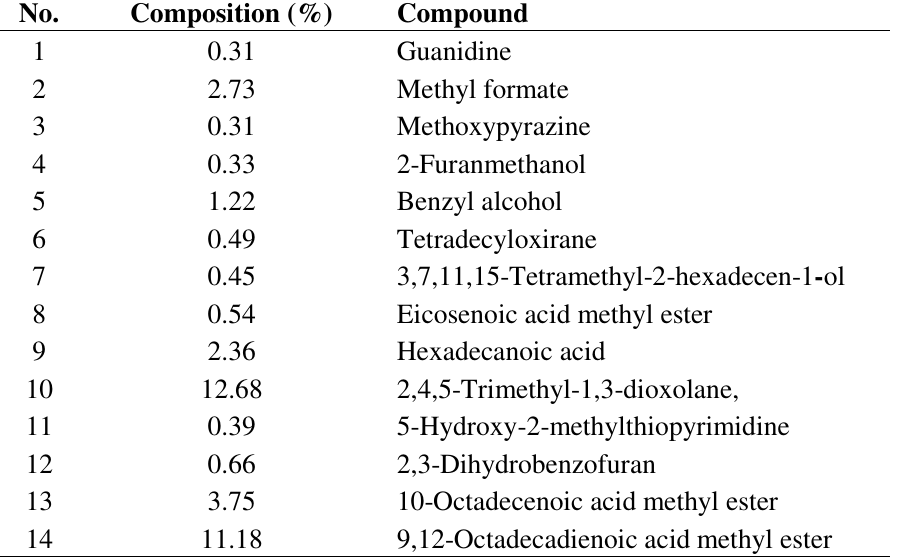
Table 8. Chemical composition of methanolic extraction of L. pumila var.